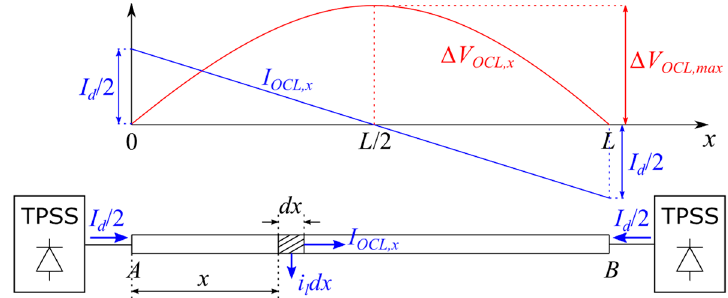
Figure 4. Bilateral power supply with a uniformly distributed